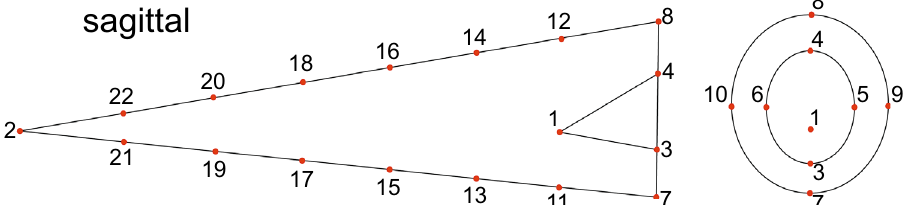
Figure 5. The positions of the 22 landmarks on the sagittal (left figure) and transversal cross section (right figure) of a schematic belemnite rostrum: The rostrum cavum is cut to 1/6th of the length of the rostrum solidum, landmarks 11–22 are curve-sliding semi-landmarks that orientate themselves equidistantly along the ventral and dorsal side of the sagittal plane through the rostrum to counteract potential inaccuracies through human